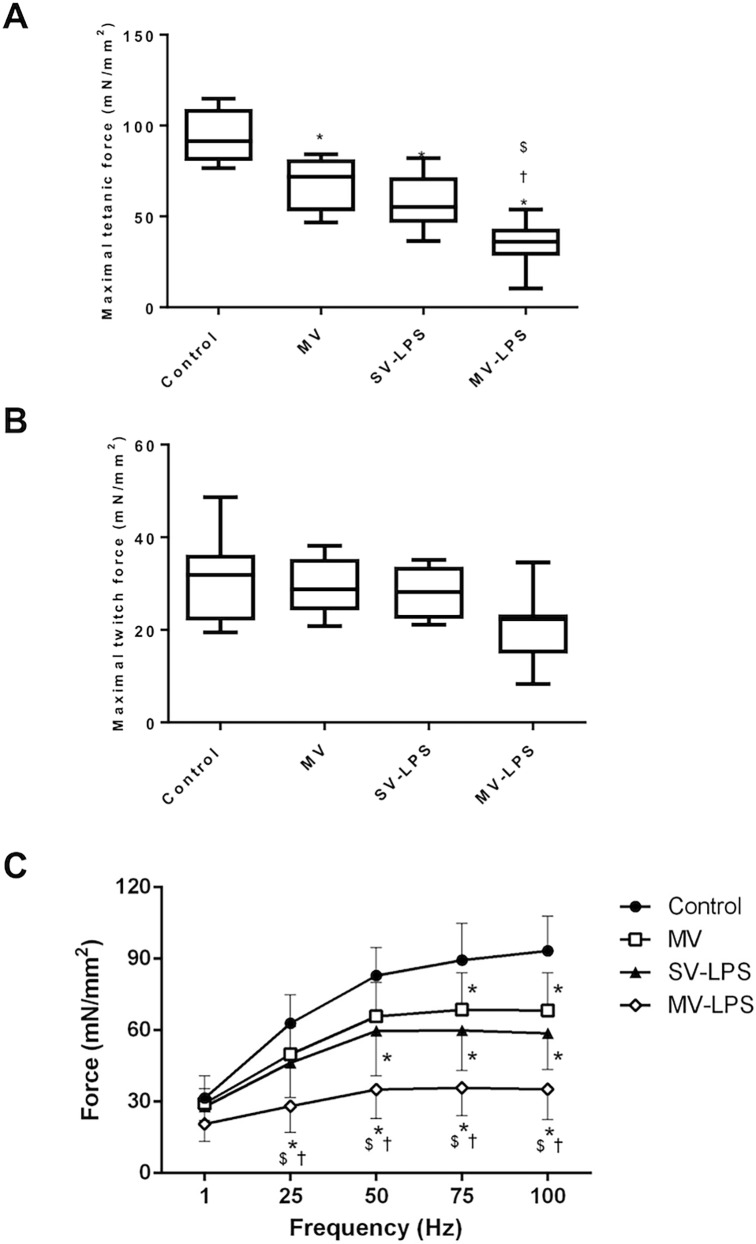
Maximal tetanic force (Panel A), maximal twitch force (Panel B) and force-frequency relationship (Panel C) of the diaphragm in the four experimental groups. Control = spontaneous ventilation without endotoxemia; MV = mechanical ventilation without sepsis; SV-LPS = endotoxemia with spontaneous ventilation; MV-LPS = endotoxemia with mechanical ventilation. Results are presented in the form of box plots. Boxes are drawn between the first and third quartiles of the distribution, black bars indicate the median, and whiskers indicate the minimum and maximum values, n = 8 per group. *: P<0.05 versus Control; †: P<0.05 versus MV; $: P< 0.05 versus SV-LPS.